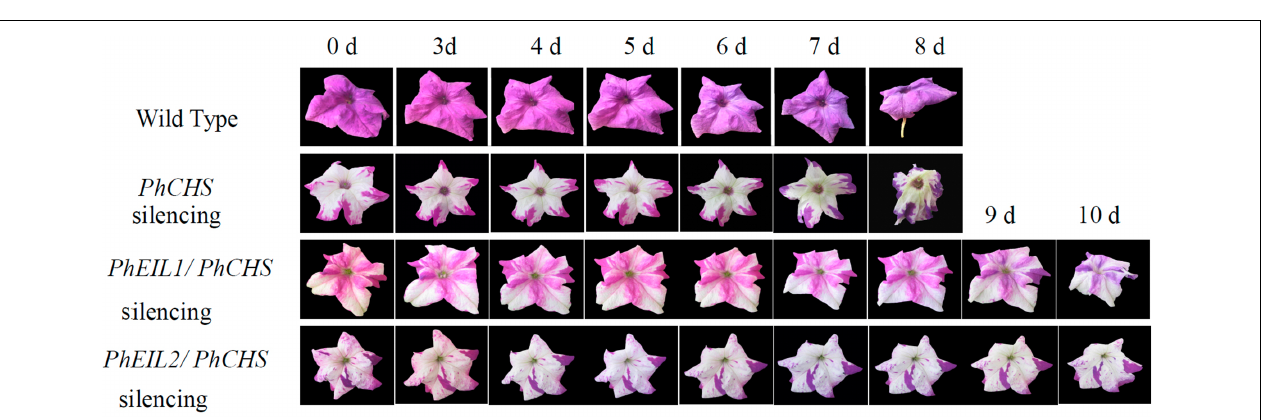
FIGURE 2 | Effects of TRV2-CHS/PhEIL1 and TRV2-CHS/PhPhEIL2 treatment on the expression of PhEIL1 and PhEIL2 in white flowers on day 4 after opening by quantitative real-time PCR, respectively. Relative expression levels are shown as fold change values. Data are mean ± SD ( n = 3). Statistical analysis was performed using one way analysis of variance (ANOVA) followed by Duncan’s multiple range test (DMRT) with three replicates. P -values ≤ 0.05 were considered as significant.